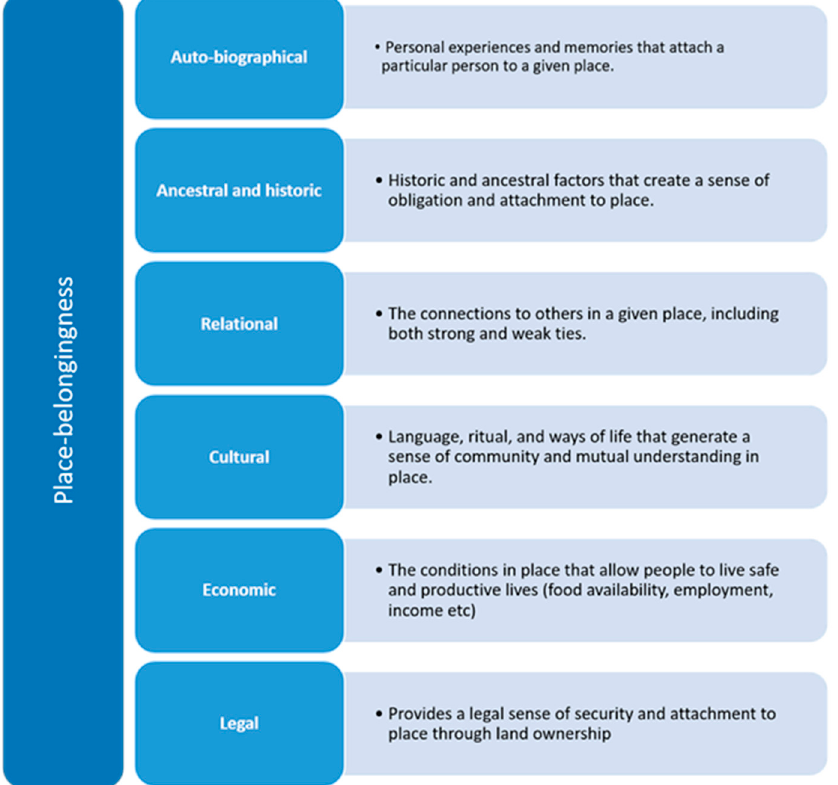
Figure 1. Conceptual framework detailing the various components of place-belongingness as autobiographical, ancestral and historical, relational, cultural, economic, and legal connections to a place (Adapted from Antonsich, 2010).